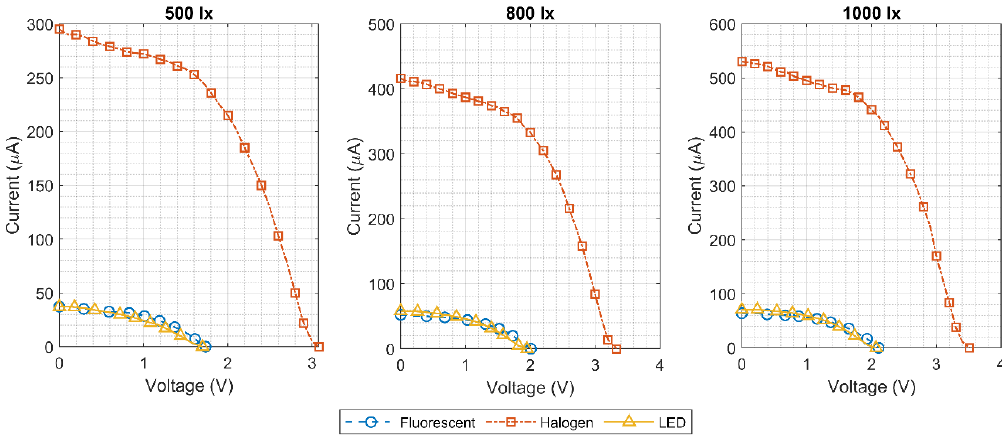
Figure 12. Measured I-V curves of three KXOB25-05X3F solar cells in series.